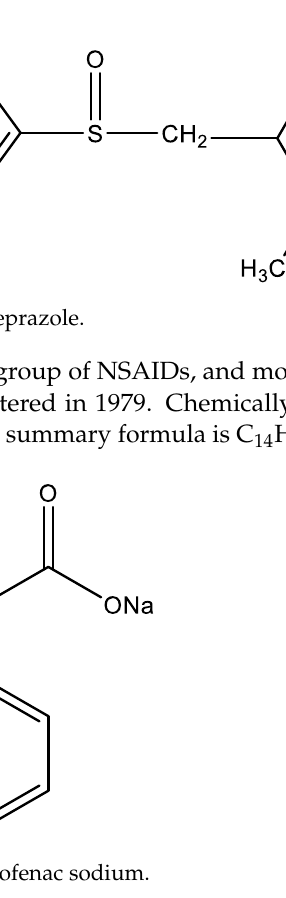
Table 1. Selected physicochemical properties of omeprazole and diclofenac sodium [9 – 13].